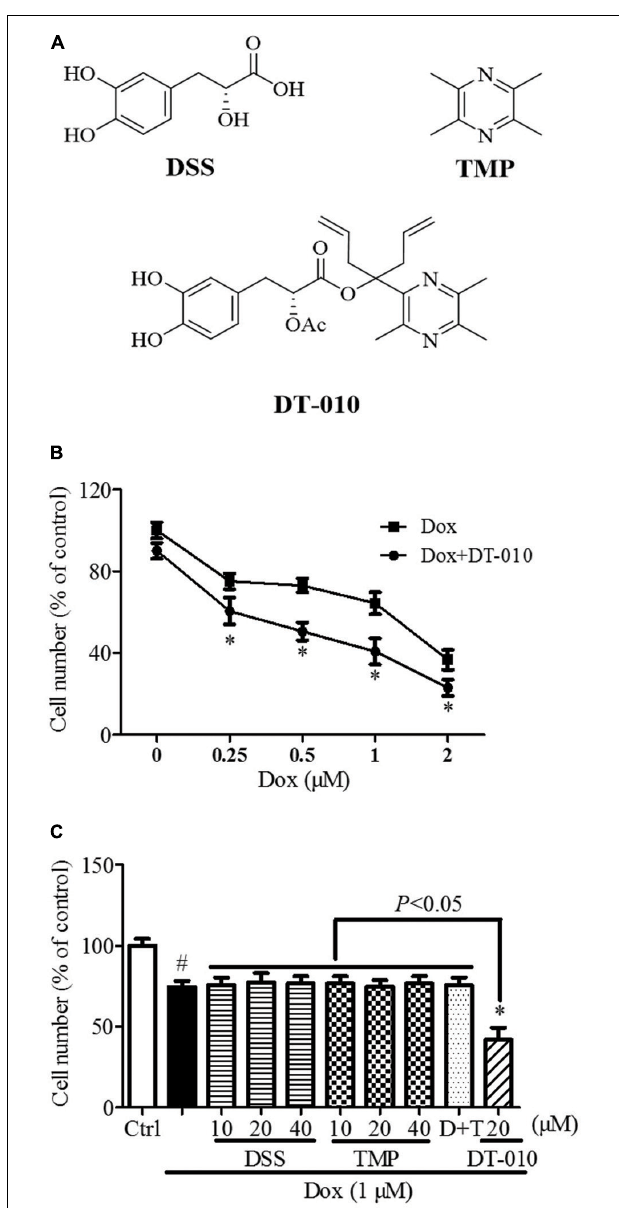
FIGURE 1 | Synergistic anti-tumor effect of DT-010 and Dox on MCF-7 breast tumor cells. (A) Chemical structures of DSS, TMP, and DT-010 (Wang et al., 2016). (B) Cell numbers of MCF-7 cells were determined after DT-010 and different concentrations of Dox treatment. (C) MCF-7 cells were treated with different concentration of DSS, TMP, D + T (DSS + TMP), DT-010 and Dox (1 µ M) for 24 h, and cell numbers were then counted. # P < 0.05 vs. Ctrl and ∗ P < 0.05 vs.